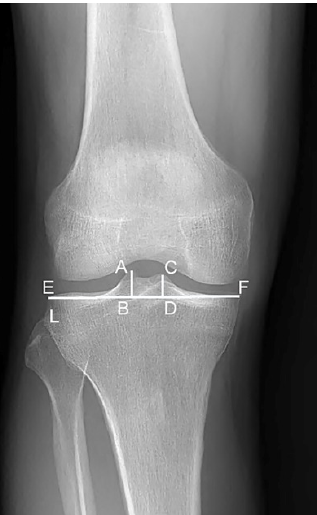
Figure 1. Morphological assessment of the tibial spine by standard radiograph. Tibial joint line connecting the most concave point of the medial tibial plateau and the most convex point of the lateral tibial plateau is shown (Line L). The length between the intersections of the L-line with the tibia condyles (E and F) is regarded as the tibial plateau width (TPW). The distances between the top of the tibial spine (A and C) and line L is regarded as the lateral tibial spine height (LTSH) or medial tibial spine height (MTSH). BD is considered as the tibial spine width (TSW).